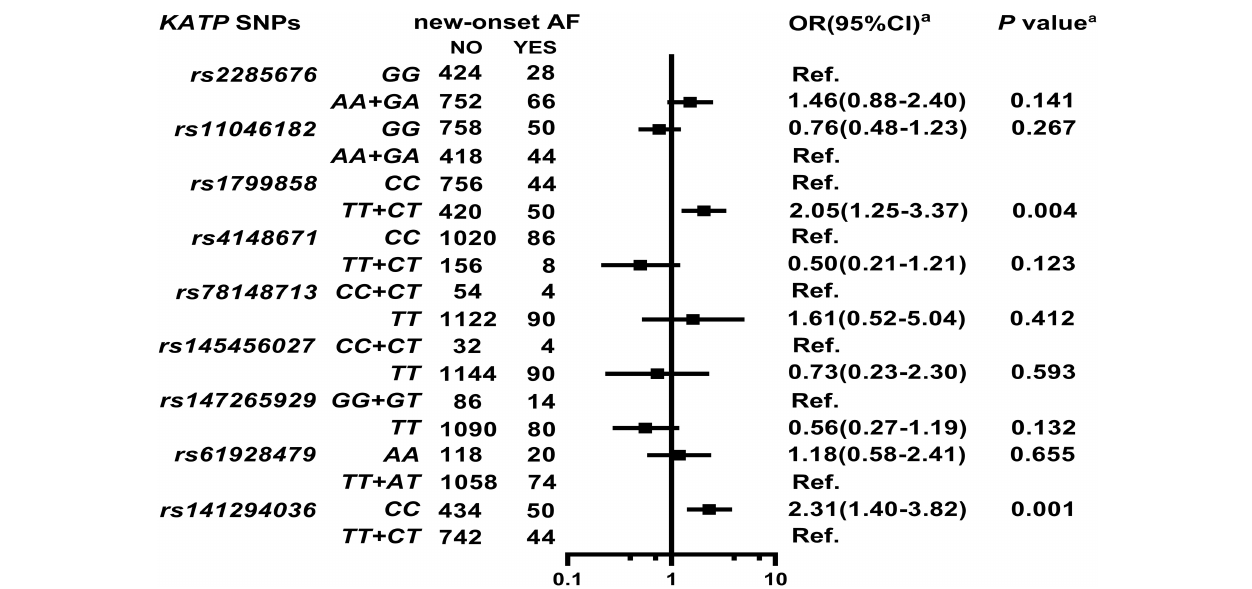
FIGURE 5 | Association of KATP SNPs with the new-onset of AF in the study participants. a Model: After adjustment for gender, age, smoking, alcohol consumption, BMI, WBC, blood glucose levels (FBS, P2hBS and HbA1C), liver function (ALT, AST and Alb), renal function (Scr, BUN, and UA), serum sodium and potassium levels, HsCRP, RAAS activity (ACE, renin, Ang I, Ang II and ALD), dyslipidemia [TRIG, TC, LDL-C, ApoB, HDL-C, ApoA-I and Lp(a)], medical condition [T2D, HTN, CAD(ACS), and HF], echocardiography index (RVD, RAD, LVD, LAD, and LVEF), and combined medication (antiplatelet drugs, warfarin, statins, RSIs, BBs, MRA, CCBs, diuretics, digoxin, nitrates, and hypoglycemic agents).